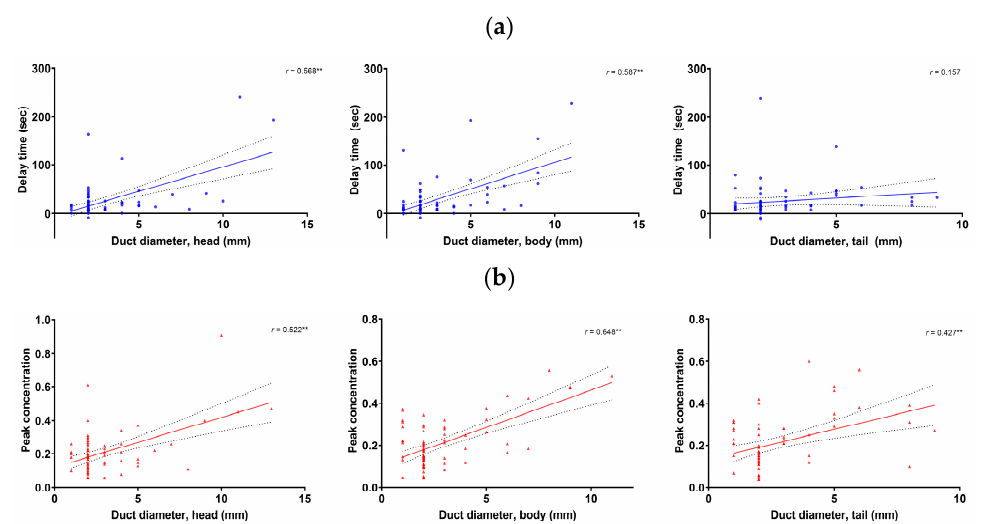
Figure 4. Correlation between the pancreatic duct diameter and the delay time ( a ) and peak concen- tration ( b ) in the pancreas head ( left ), body ( mid ), and tail ( right ), respectively. **: p < 0.001.